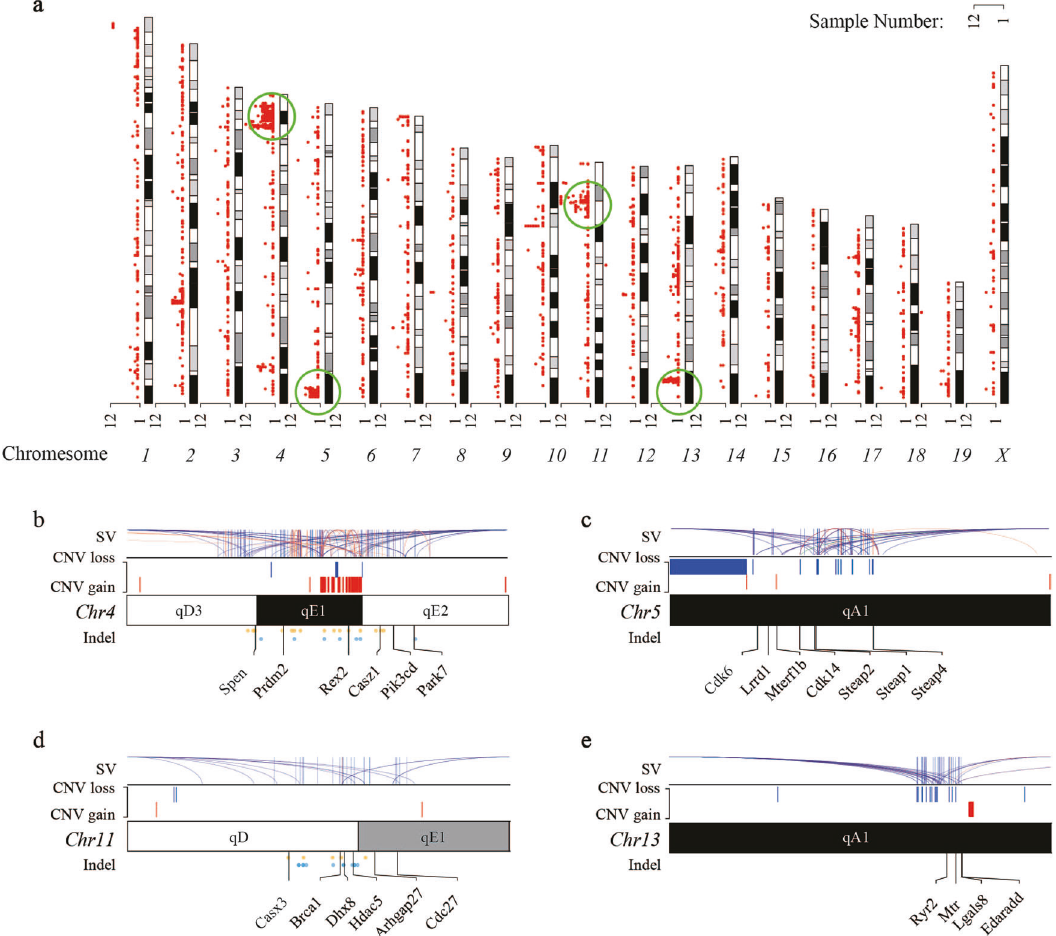
Fig. 3 Variant distribution across different chromosomes. a Distribution of SV breakpoints in Brca1 + / − mice. Red dot represents the frequency of breakpoint occurrence in the corresponding site. Green circle marks the clustered region. Variant distribution of Brca1 + / − mice in the four major SV clusters detailed in ( b – e ). ( b ) chr4: 139320925 – 151922486; ( c ) chr5 3152512-8342821; ( d ) chr11: 96075557-107346908; ( e ) chr13: 111440505-3139770. Each cluster shows SVs [purple: break end (BND); orange: inversion; red: duplication; blue: deletion)], CNVs (blue: loss; red: gain) and Indels (yellow: insertion; blue: deletion). The curves in SVs refer to their interaction with other genomic regions. Chromosomal bands are indicated in each cluster. Representative genes affected are listed at the bottom of each